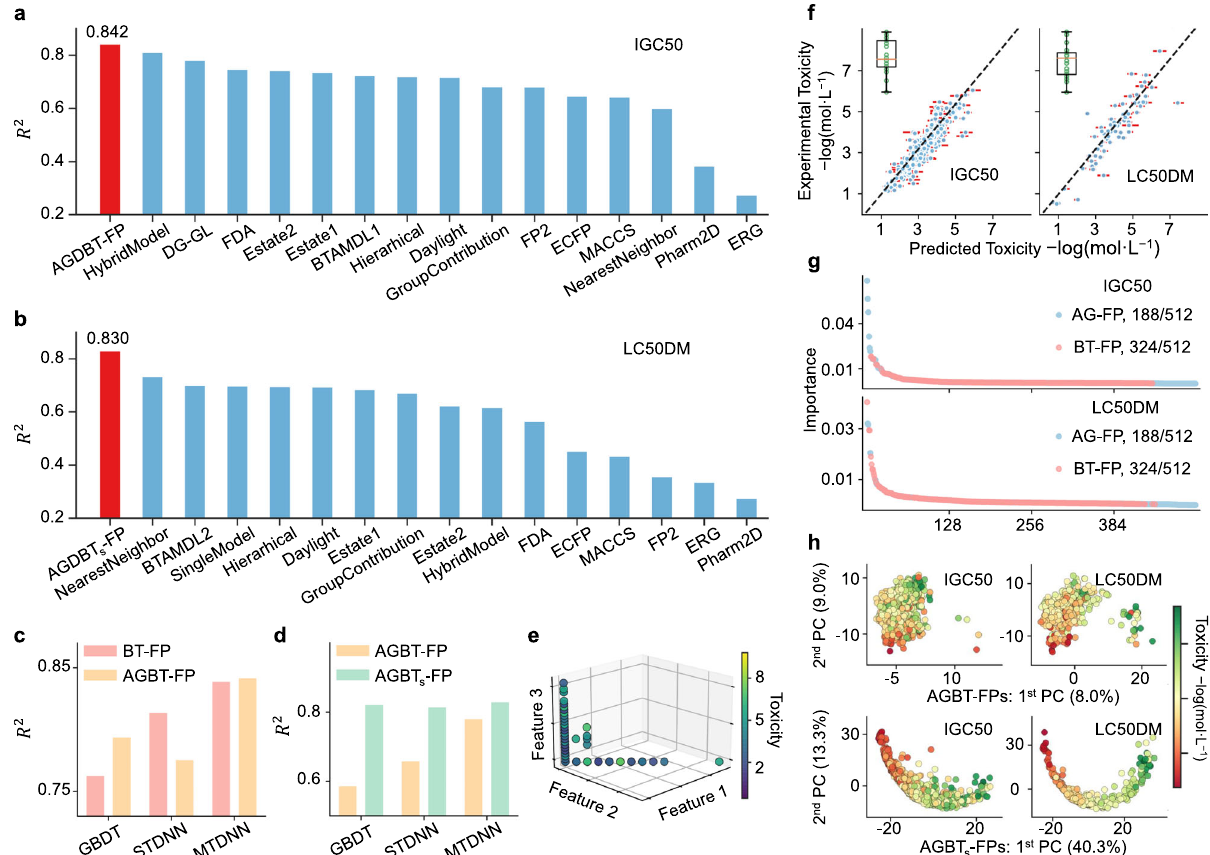
Fig. 2 Results from AGBT framework and feature analysis. a , b Illustrate the comparison of the R 2 by various methods for the IGC50 set and the LC50DM set, respectively. AGBT s -FP means a supervised fi ne-tuning process is applied to AGBT-FP. The other results were taken from refs. 2,13,17,23,40,41 . c The bar charts illustrate the R 2 of AGBT-FPs and BT-FPs with three machine learning algorithms for the IGC50 dataset. d The bar charts illustrate the consensus R 2 of AGBT-FPs and AGBT s -FPs with three machine learning algorithms for the LC50DM dataset. e Visualization of the LD50 set. The axes are the top three important features of AGBT-FPs. f Predicted results of AGBT-FPs with MT-DNN model for the IGC50 set(left) and the LC50DM set(right), respectively. The box plots statistic R 2 values for n = 358 (left), and 70 (right) independent samples examined over 20 independent machine learning experiments, and the detailed statistic values are listed in Supplementary Table 5. g The AGBT-FPs of the IGC50 and LC50DM datasets were ranked by their feature importance. For both datasets, 188/512 of the AGBT features are from AG-FPs and the remaining 348/512 are from BT-FPs. h Based on AGBT-FPs and AGBT s -FPs, the variance ratios in the fi rst two components from the principal component analysis (PCA) are used to visualize the IGC50 and LC50DM